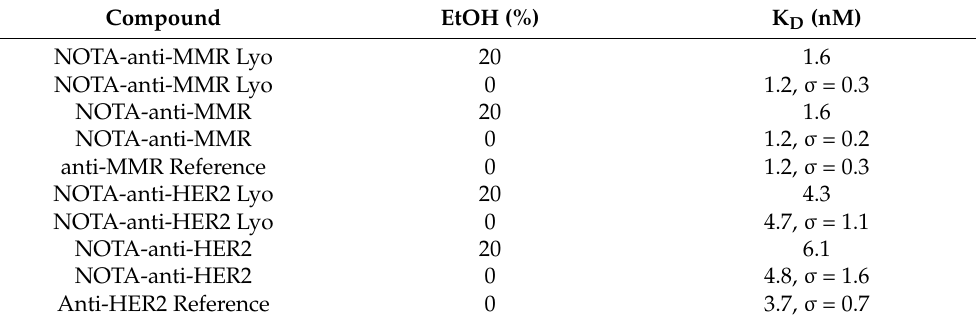
Table 4. Effect of pre-incubation of NOTA-sdAbs with EtOH on precursor affinity, as measured via